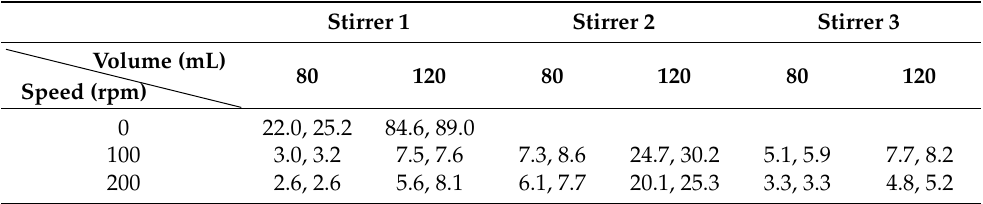
Table 5. Mass-transfer time constants (hours) for 0.3 g benzoic acid tablets dissolved in deionized water (beaker and stirrer system). Stirrer 1 Stirrer 2 Stirrer 3